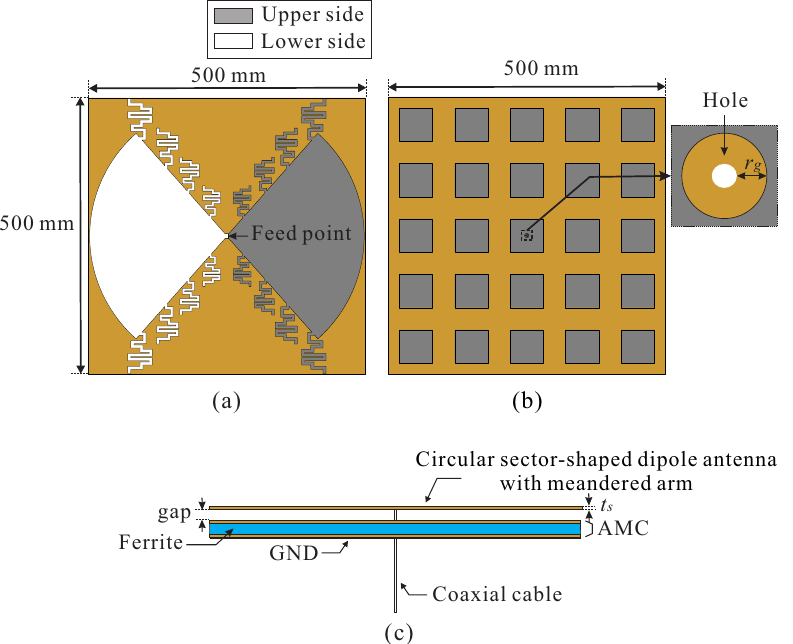
Figure 4. Configuration of proposed antenna with the AMC structure: ( a ) circular sector-shaped dipole antenna; ( b ) 5 × 5 AMC structure; ( c ) side